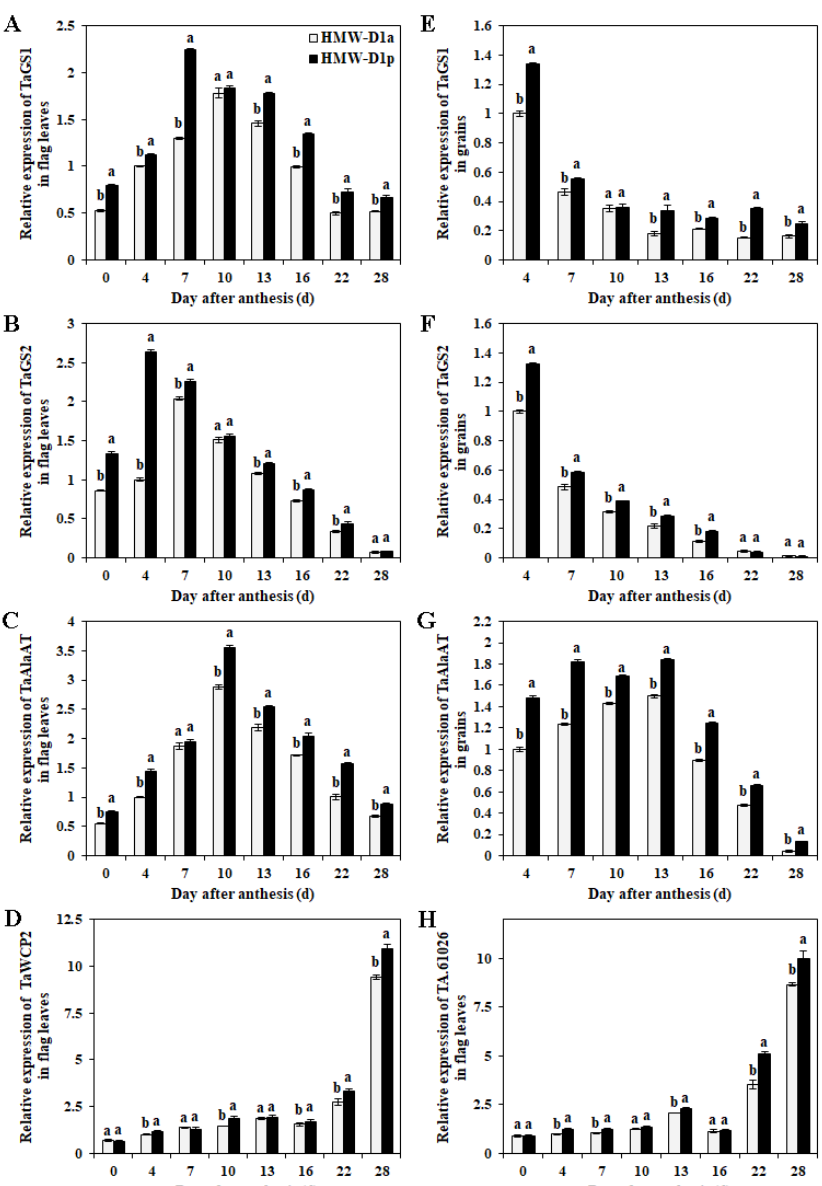
Figure 6. Expression levels of genes related to nitrogen metabolisms in flag leaves ( A–D , H ) and grains ( E–G ) from HMW-D1a and HMW-D1p in 2018–2019 growing season. ( A , E ), TaGS1; ( B , F ) TaGS2; ( C , G ) TaAlaAT; ( D ) TaWCP2 encoding cysteine protease; ( H ), TA.61026 encoding thiol protease. Gray column represents HMW-D1a and black column represents HMW-D1p. Results followed by a di ff erent letter in the same column within the same group are significantly di ff erent ( p < 0.05).